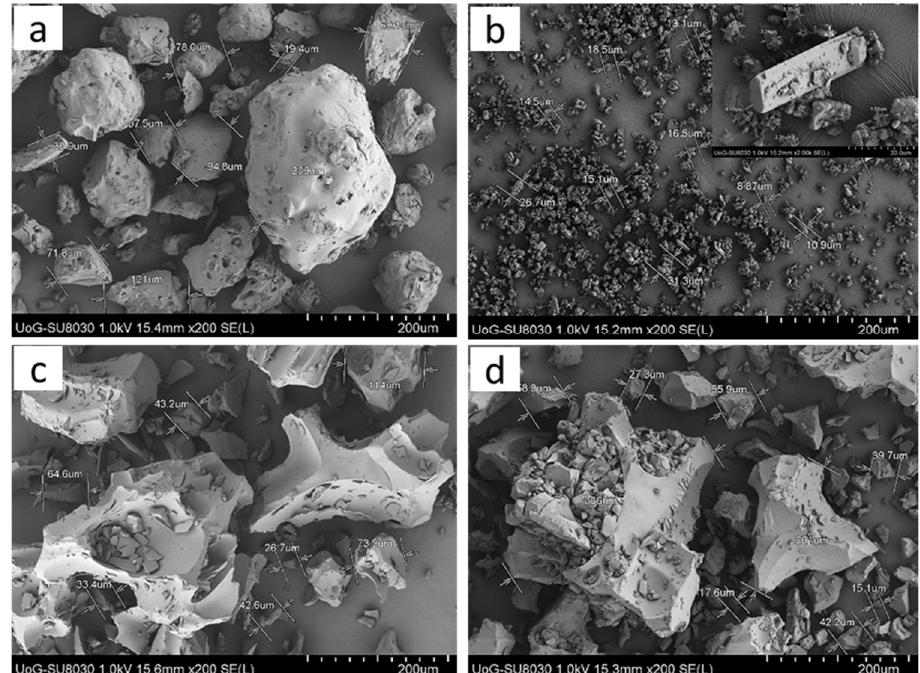
Figure 5. SEM micrographs (200×) of ( a ) Soluplus ® , ( b ) Simvastatin (inset-2000×), and solid dispersions (( c ) SD10 and ( d ) SD30).